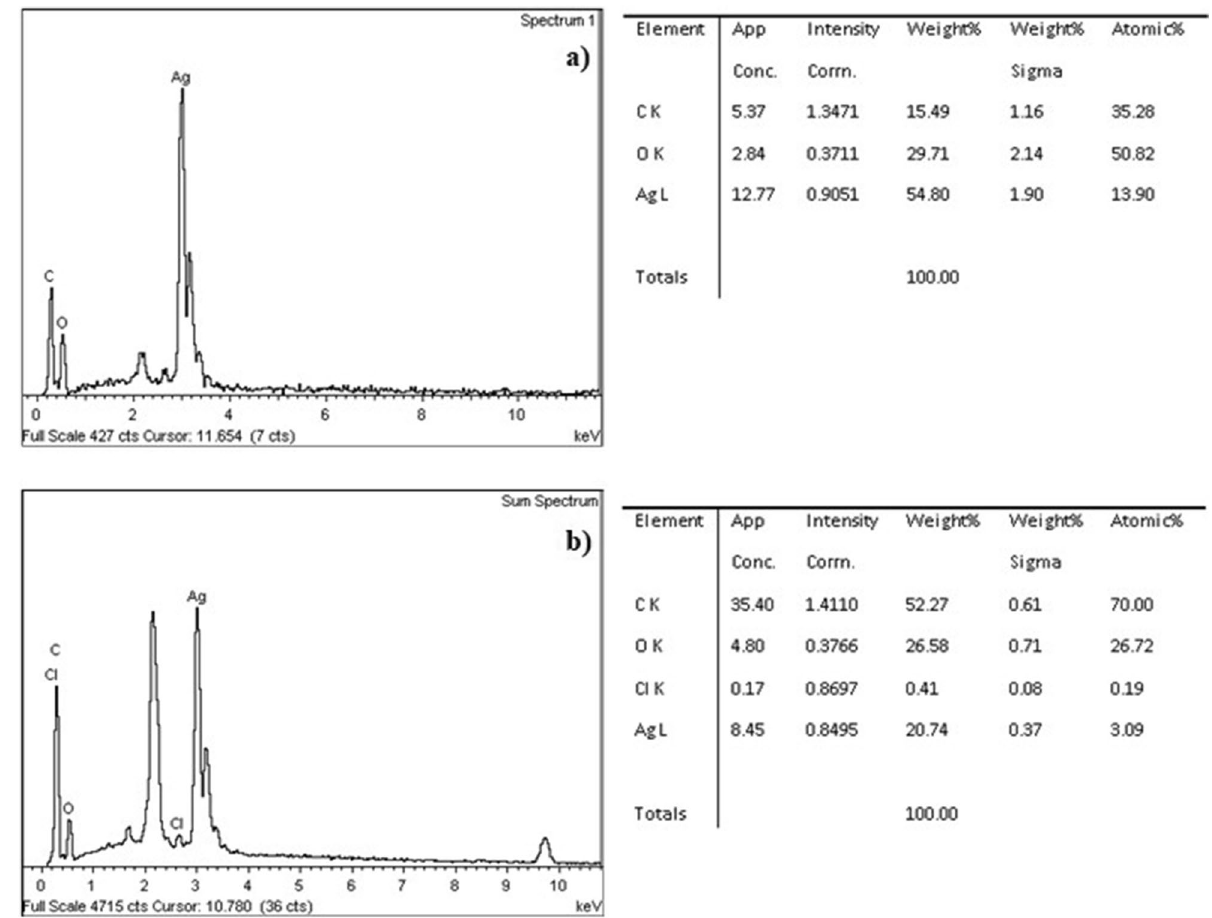
Figure 12. EDX spectra-data of the fungal mycelium anamorphous Bjerkandera sp. R1 treated with a 1 mM